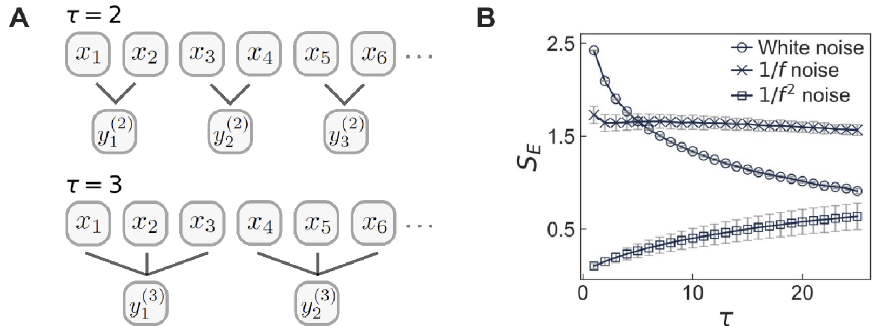
Fig 2. Multiscale entropy (MSE) method. (A) A schematic illustration of coarse-graining procedure of the time series { x t } for t = 1, ... , T with the scale factor τ = 2 (top) and 3 (bottom). (B) Numerical results of the MSE method applied is averaged over 10 time series with T = 3 × 10 4 , to the white noise, the 1/ f noise, and the 1/ f 2 noise. Each value of S E and the error bar denotes its standard